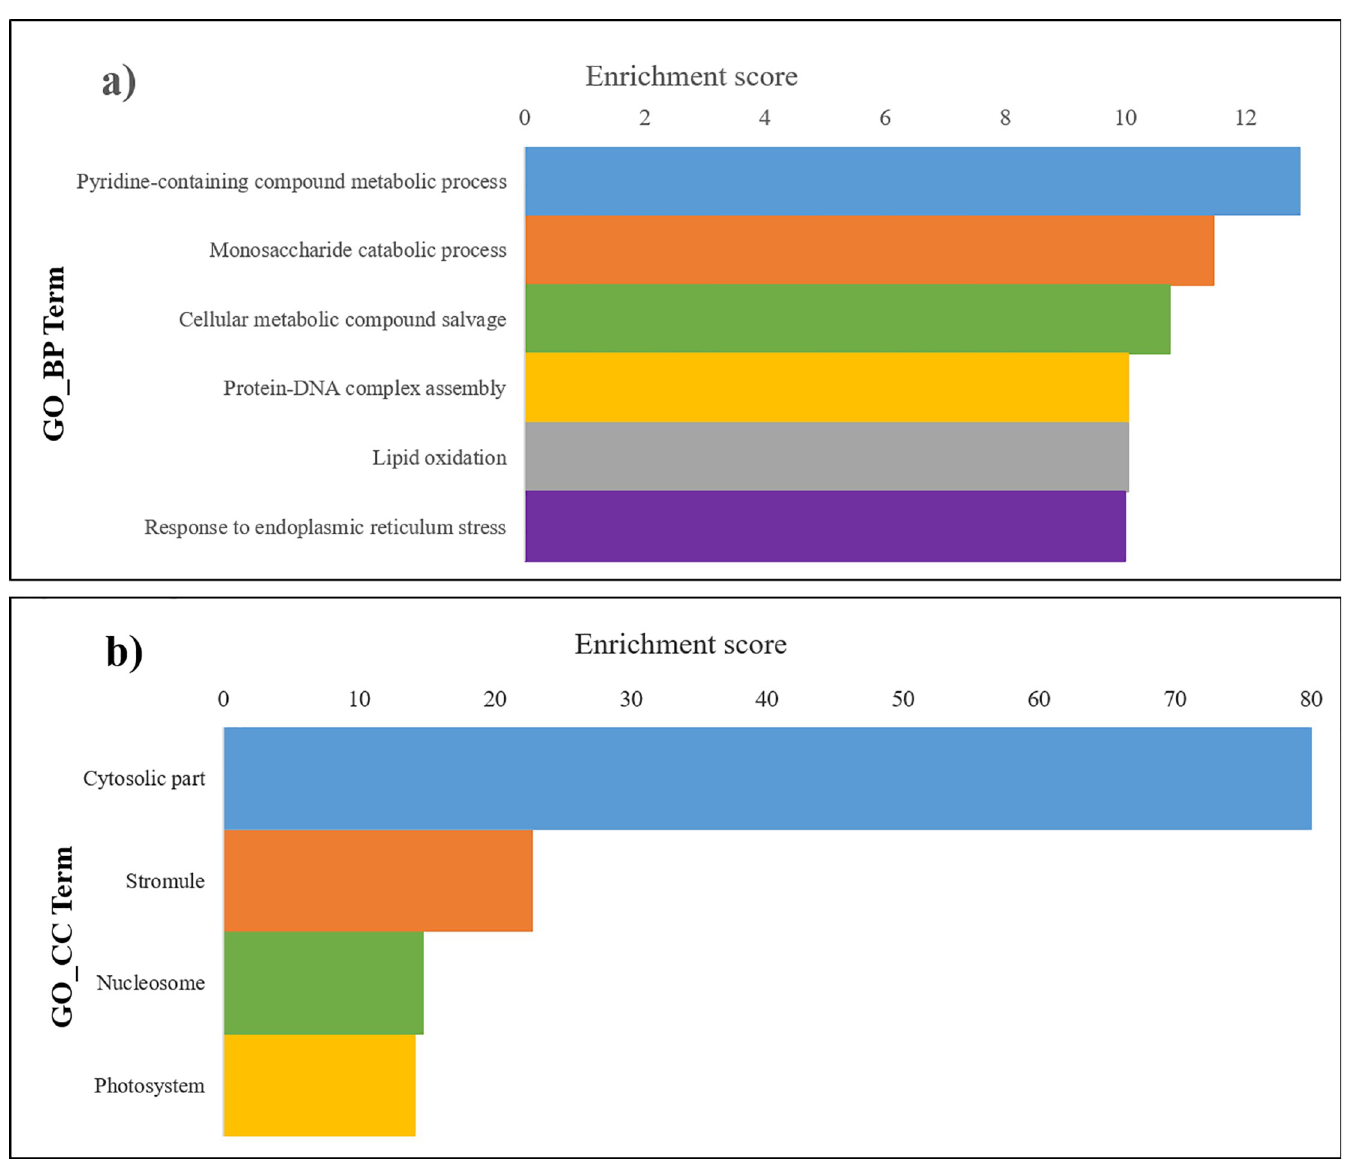
Fig 3. Enrichment analysis applied to the subset of 80 differential proteins. The bars represents the groups with higher enrichment score [ − log2 (group FDR)] obtained for each group of functional related GO terms; the enrichment of the Gene Ontology category of GO_BP are showed in panel a), and those for GO_CC in panel b). Each group is labelled by the most significant ( < FDR) enriched term, used as representative of the total enriched terms in each group that can be consulted in detail in S4 and S5